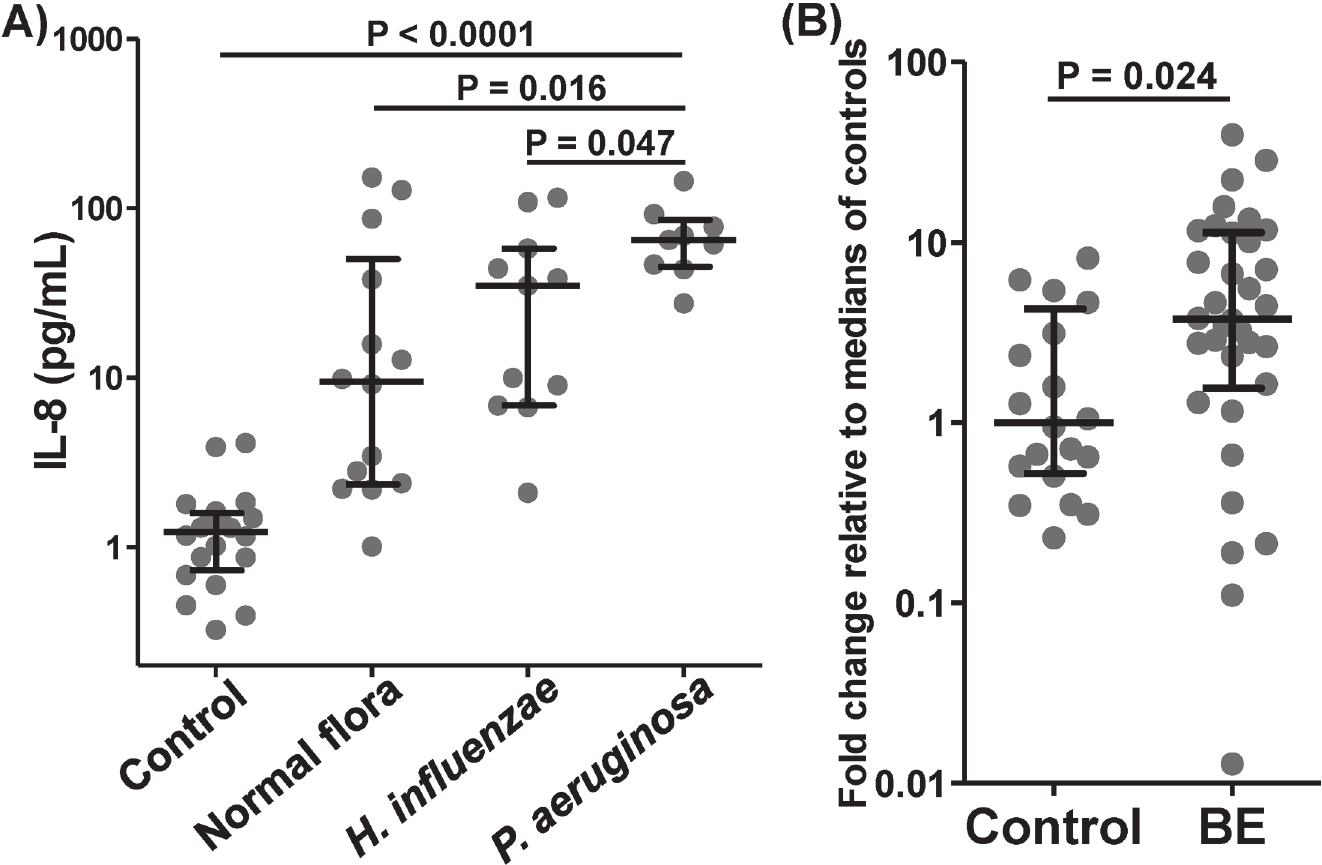
Fig 3. Airway luminal and bronchial mucosal levels of IL-8 are increased in non-CF bronchiectasis and relate to airway microbiology. (A) Bronchoalveolar lavage IL-8 levels are significantly increased in bronchiectasis subjects according to concurrent BALF infection by P . aeruginosa (n = 9) compared to H . influenzae (n = 11), normal respiratory flora only (n = 14) and healthy controls (n = 20). (B) Gene expression of IL-8 is significantly increased in endobronchial biopsy tissue from adult non-CF bronchiectasis (n = 34) than control (n = 20) subjects. (Cont — control, BE — bronchiectasis; Box and whisker plots display median and interquartile ranges; p values by Mann-Whitney U test).